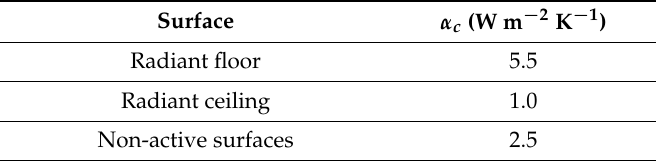
Table 6. Convective heat transfer coefficient of each surface of the room.